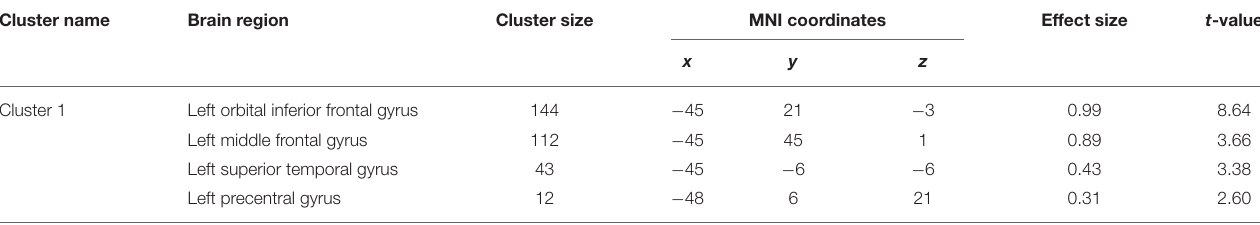
TABLE 4 | Regions showing significant difference in FC analysis between Group C and Group I at 7 days after